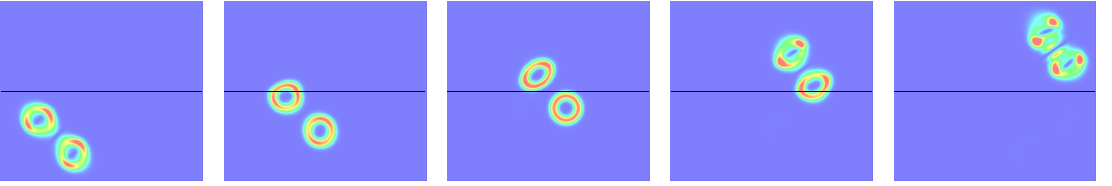
Figure 12. Refraction of a toroidal-vortex at the interface of (cid:101) 2 / (cid:101) 1 = 0.75 with the incident angle of 45 ◦ .